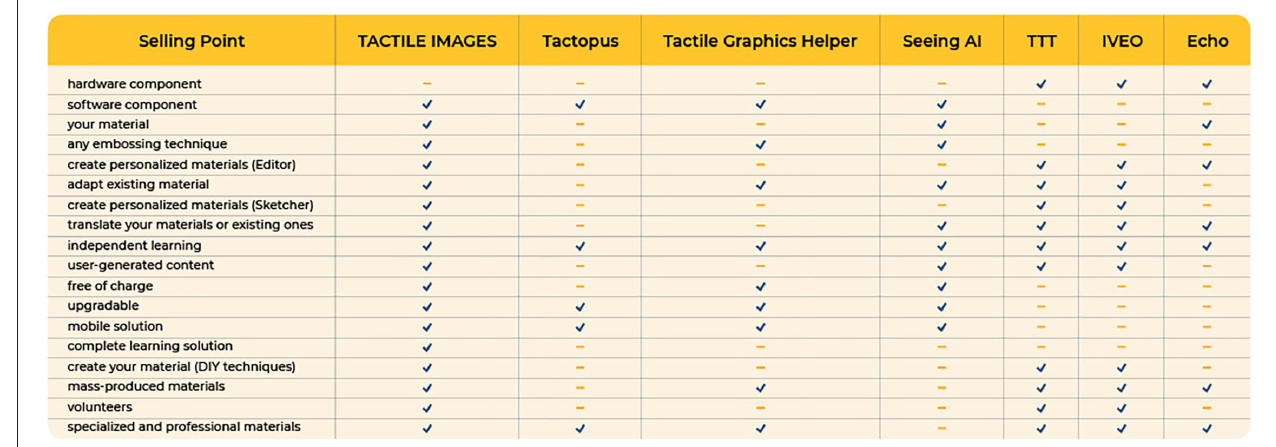
FIGURE 2 | Benchmarking for tactile images.